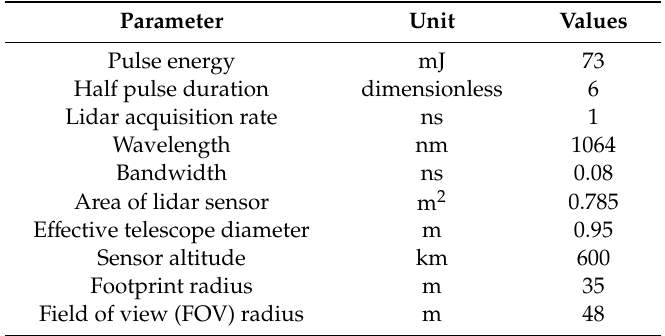
Table 1. Values for the discrete anisotropic radiative transfer (DART) model used in this study are consistent with the GLAS device configuration, as mentioned in the text.